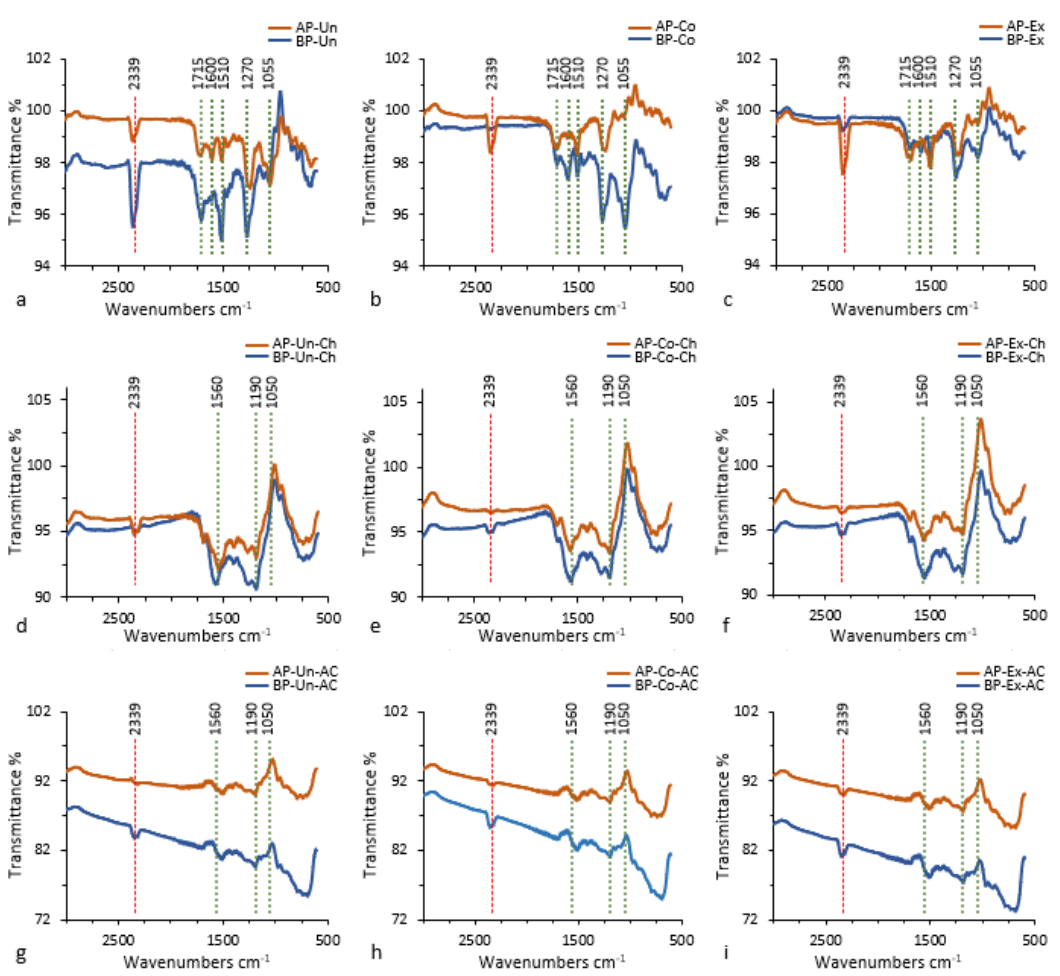
Figure 1. Typical infrared spectra of Leopoldinia piassaba and Attalea funifera Martius raw, milled fibers ( a – c ), charcoal precursor ( d – f ) and activated carbon ( g – i ). Fibers without pretreatment ( a , d , g ), fibers pretreated by Corona electrical discharge ( b , e , h ) and fibers pretreated by solvent extraction ( c , f , i ). The vertical lines ( a – c ) correspond to specific functional groups: 1715 cm − 1 (C = O), 1600 cm − 1 (C = C of the aromatic ring of lignin plus C = O), 1510 cm − 1 (lignin backbone), 1270 cm − 1 (lignin guaiacyl ring plus C = O) and 1055 cm − 1 (C-O(H) of carbohydrates). Note that BP-Un and AP-Un (a) have the same intensity at peaks 1270 and 1055 cm − 1 . The peak at higher intensity at the peak 1510 cm − 1 in AP-Un compared to BP-Un is indicative of higher lignin in AP-Un than in BP-Un. The peaks at 1560 cm − 1 , attributed to C = C of the aromatic skeleton, indicates dehydrogenation, the formation of double bonds and aromatization of the material in AP-Un-Ch and BP-Un-Ch). The 1050 cm − 1 peak has disappeared ( d , e ), suggesting carbohydrate degradation. The peak at 1190 cm − 1 shows the change of aromatic structure of the lignin due to the carbonization. The pretreatments had no significant e ff ect on either charcoal or activated carbons ( d – i ). AP, L. piassaba (Amazon piassava); the peaks at 2339 correspond to CO 2 stretching ( a – i ). BP, A. funifera (Bahia piassava); Ch, charcoal; AC, activated carbon; Un, untreated (no pretreatment); Co, Corona electrical discharge pretreatment; Ex, solvent extraction